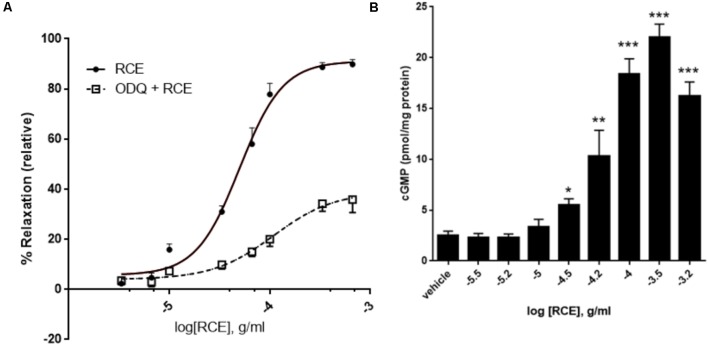
Role of guanylyl cyclase and cGMP in RCE-induced relaxation. (A) Endothelium-intact aortic rings were subjected to cumulative doses of sumac without (circles; RCE) or with pre-incubation with ODQ (1 μM; squares; ODQ + RCE). Data represent mean ± SEM (n = 7; p < 0.01 for RCE versus ODQ + RCE). (B) Accumulation of cGMP in aortic rings in the absence or presence of increasing doses of RCE. Each bar represents mean ± SEM (∗p < 0.05, ∗∗p < 0.001, and ∗∗∗p < 0.0001).